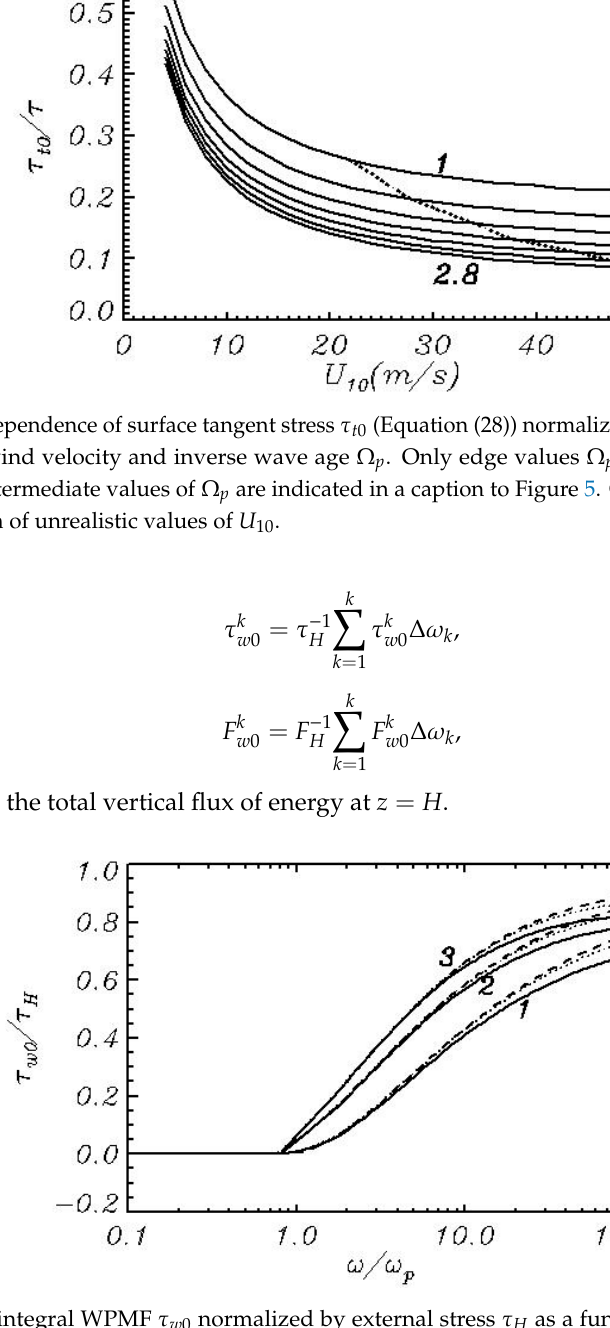
Figure 10. The integral WPMF τ w 0 normalized by external stress τ H as a function of ω / ω p , and Ω p : Figure 10. The integral WPMF 0 w 1— U H = 14 m / s; 2—22 m / s ; 3—30 m / s. Solid curves correspond to Ω p = 1; dotted curve to Ω p = 1.9, Ω : 1— / . m s Solid curves correspond to dashed curves to Ω p = p curve to dashed curves to 2.8